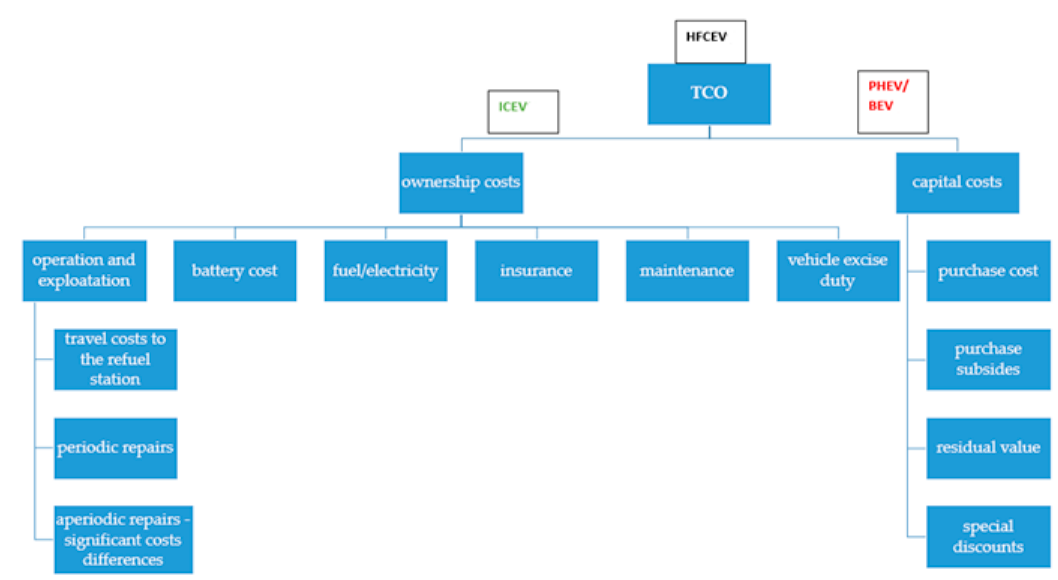
Figure 1. Breakdown of the total cost of ownership of vehicles equipped with different types of drives due to different indirect costs.